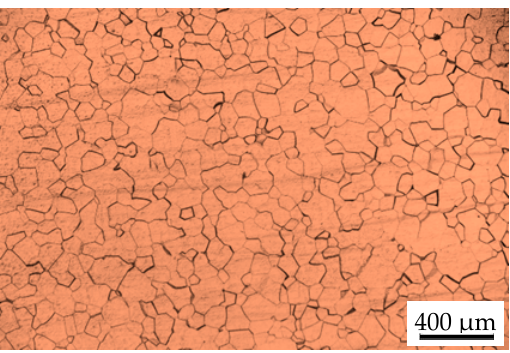
Figure 1. Microstructure of the samples after solution-treatment at 900 ◦ C for 30 min.